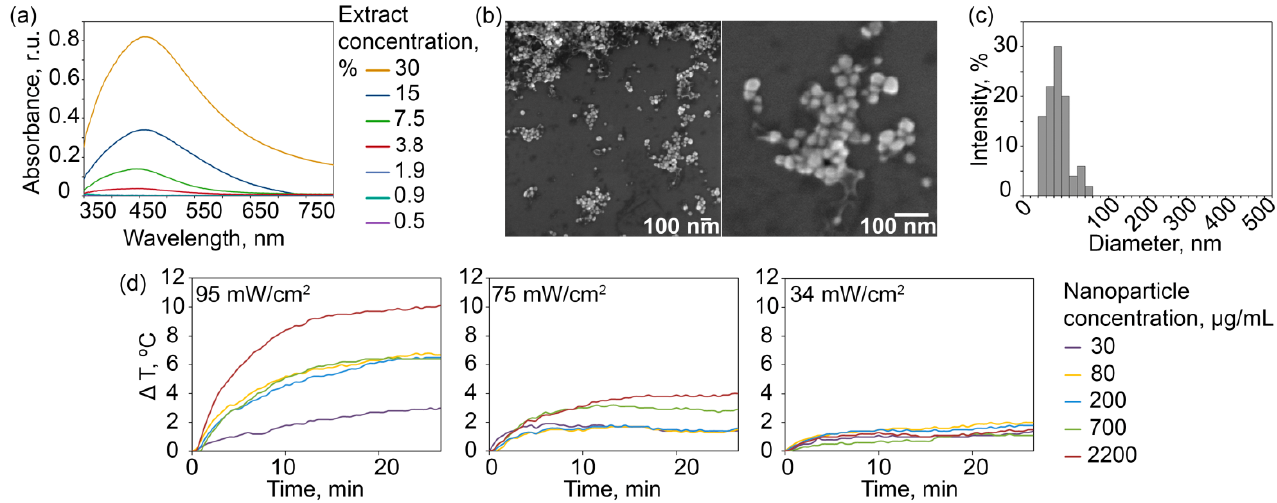
Figure 2. Synthesis, characterization, and optical and photothermal properties of Ag NPs. ( a ): Absorption spectra of NPs in the wavelength range of 350–800 nm, obtained by spectrophotometry during the 240 min incubation of an aqueous solution of silver nitrate (1 g/L) and plant extract at 0.5–30% concentrations. ( b ): Electron micrographs of Ag NPs obtained by scanning electron microscopy (scales, 100 nm). ( c ): Histograms of the distribution of NP number (%) by size (nm). ( d ): Dynamics of temperature change (°С) of different NP concentrations (g/L) under the irradiation with a LED matrix at a power of 95, 75, and 34 mW/cm 2 .